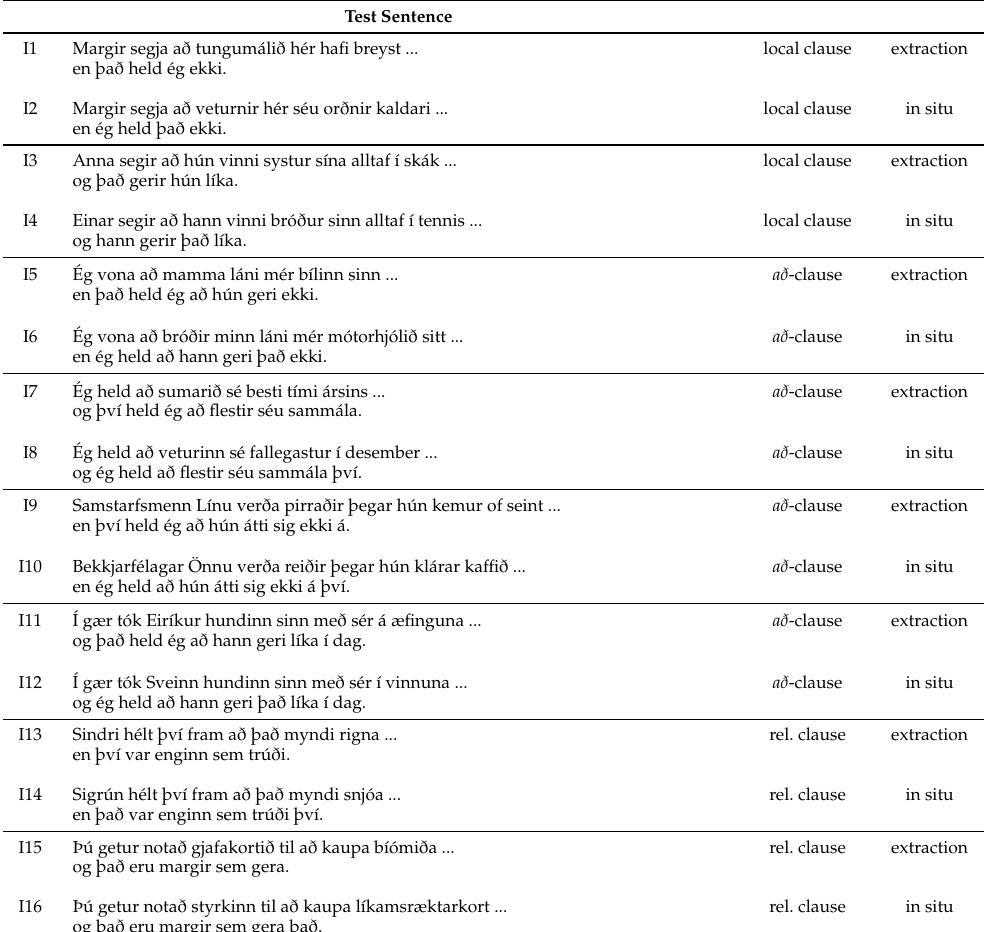
Table A3. Icelandic test